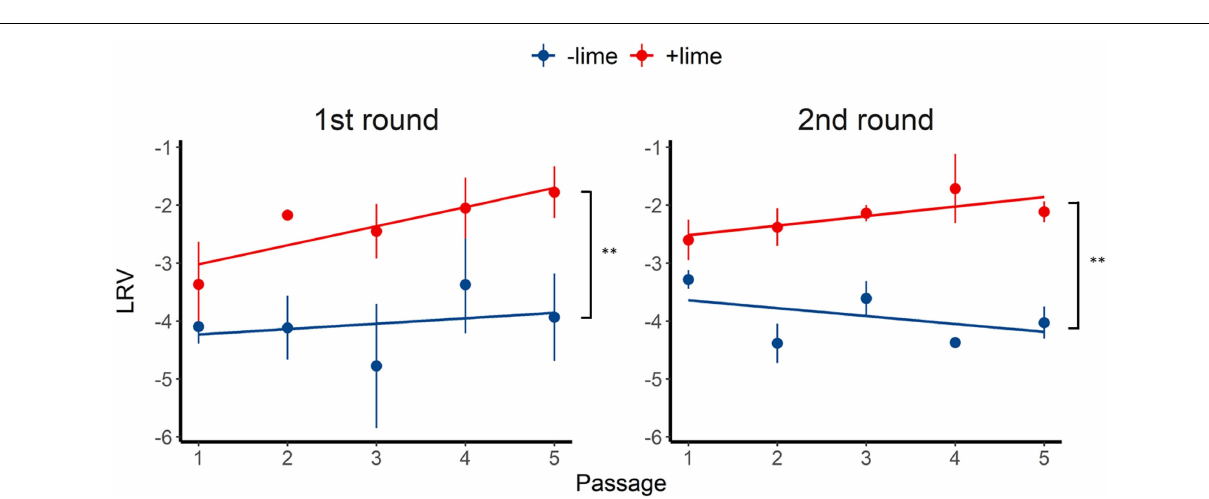
FIGURE 3 | Inactivation rate of murine norovirus (log reduction value: LRV) obtained in serial passages without ( − lime) and with (+lime) lime treatment 5 min after exposure to lime solution. Each point represents an average value from three replicates. Solid lines are linear regression lines of best fit. Asterisks indicate a statistically difference between the − lime lineages and +lime lineages ( p < 0.01 by Mann–Whitney U